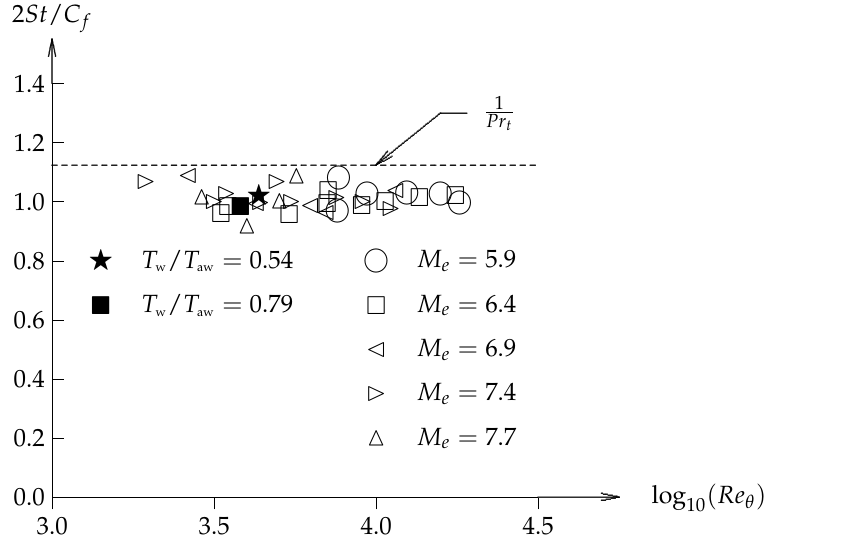
Figure 11. Scatter in Reynolds Analogy Factor (Keener and Polek [45]).